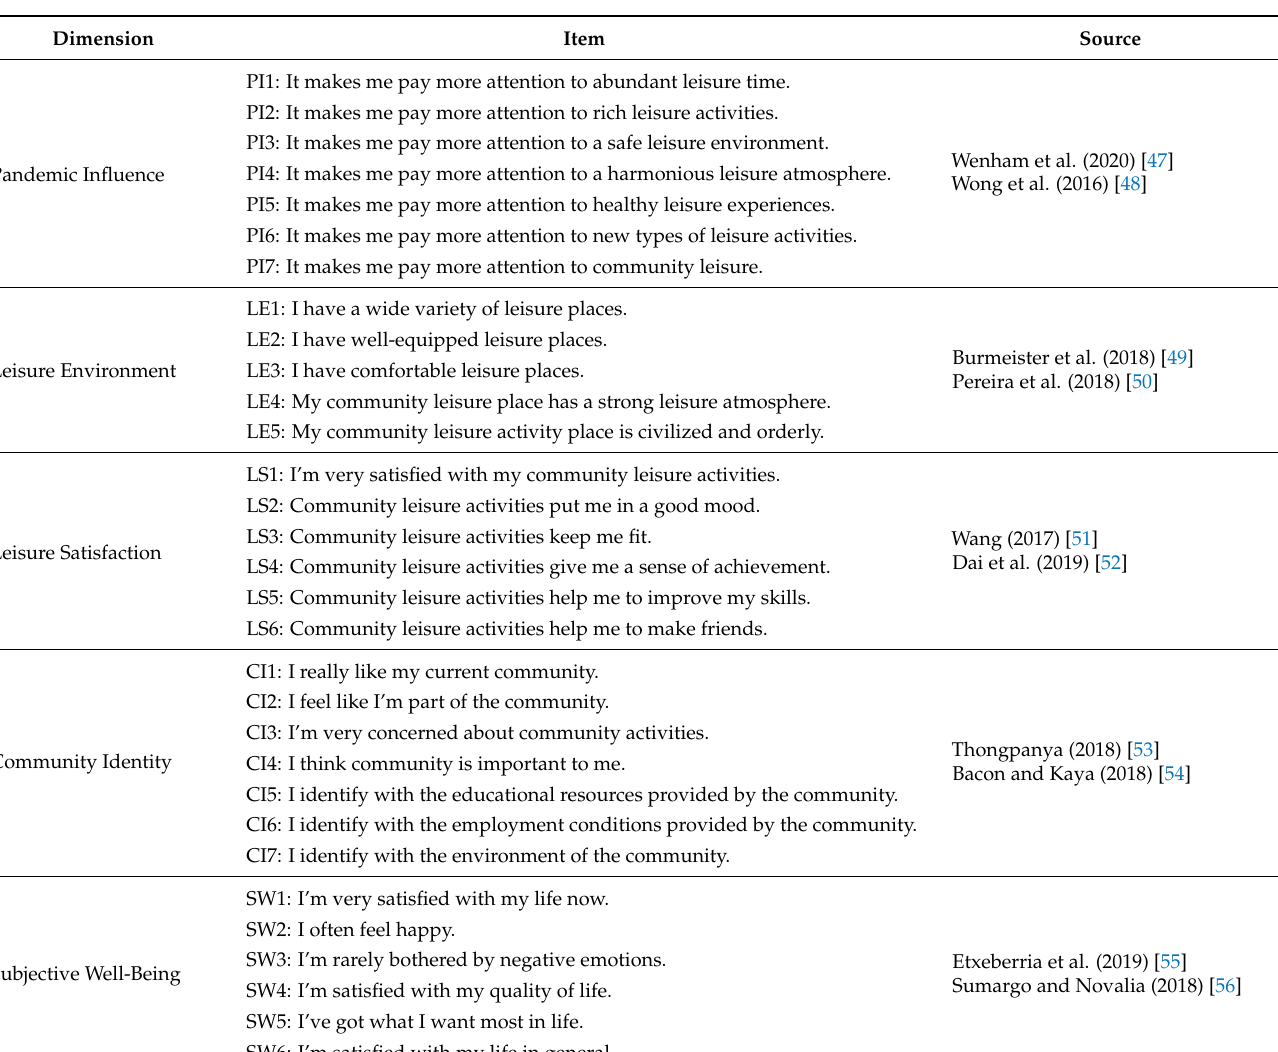
Table 1. The questionnaire items. Dimension Item Source